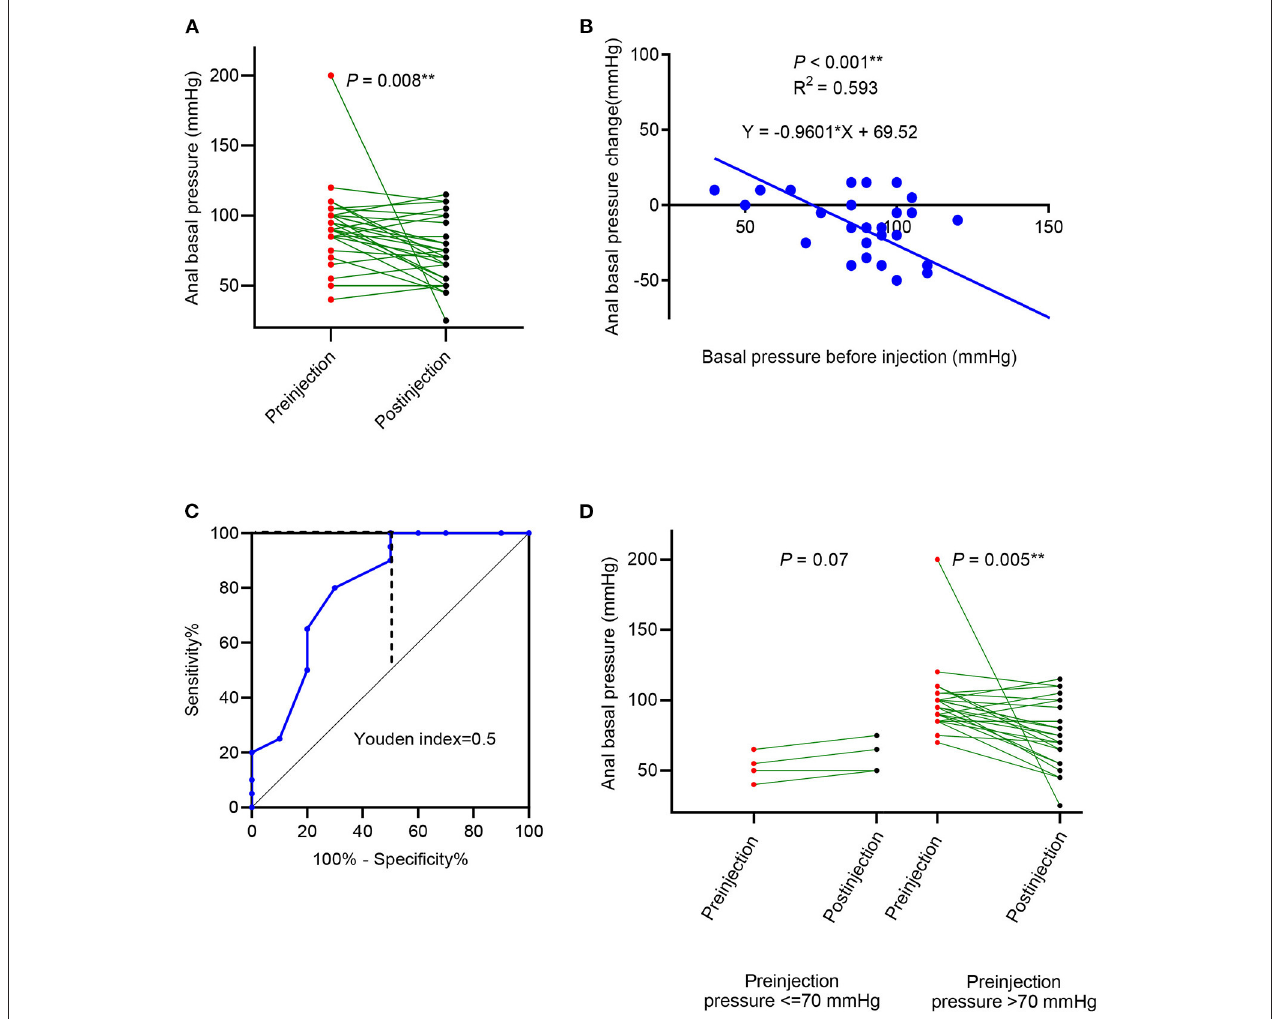
FIGURE 2 | Anal basal pressure change, after botulinum toxin injection in patients with idiopathic constipation. (A) The change in anal basal pressure after the botulinum toxin; (B) linear correlation between preinjection anal basal pressure and change in anal basal pressure; (C) receiver operating characteristic (ROC) curve using preinjection anal basal pressure to predict the decrease of anal basal pressure; (D) comparison of anal basal pressure before and after the botulinum toxin injection in patients whose anal basal pressure before injection was ≤ 70 mmHg and > 70